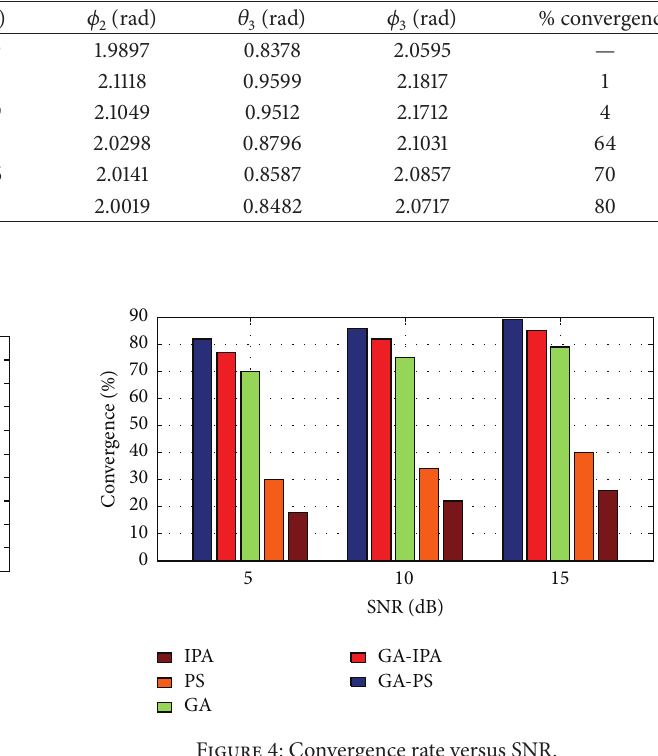
Figure 3: Convergence rate versus number of sources.